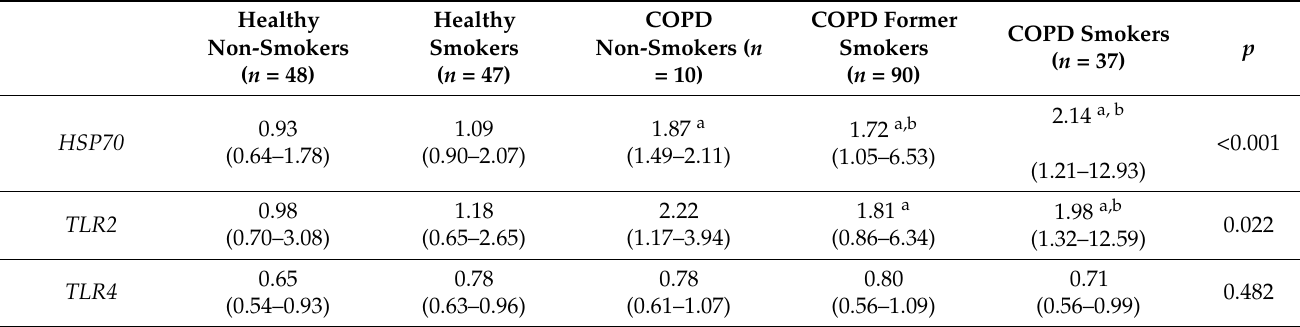
Table 5. Relative expression of HSP70 , TLR2 and TLR4 in controls and COPD patients based on smoking